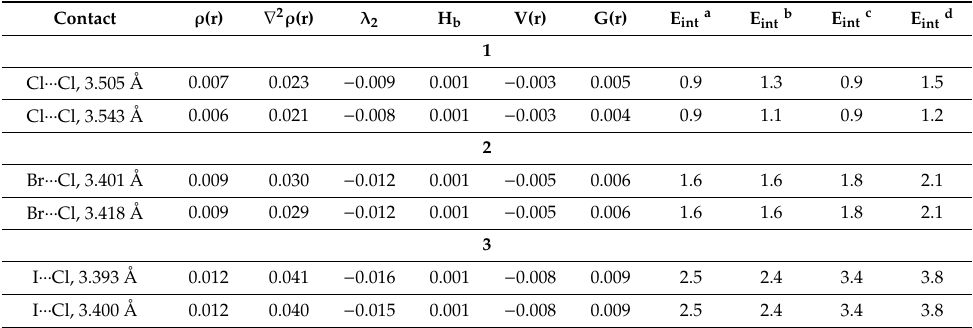
Table 1. Values of the density of all electrons – ρ ( r ), Laplacian of electron density – ∇ 2 ρ ( r ) and appropriate λ 2 eigenvalues (with promolecular approximation), energy density – H b , potential energy density – V( r ), and Lagrangian kinetic energy – G( r ) (a.u.) at the bonding of critical points (3, − 1), corresponding to intermolecular non-covalent interactions X ··· Cl (X = Cl, Br, I) in 1 , 2 , and 3 , as well as energies for these contacts E int (kcal / mol), defined by di ff erent approaches.